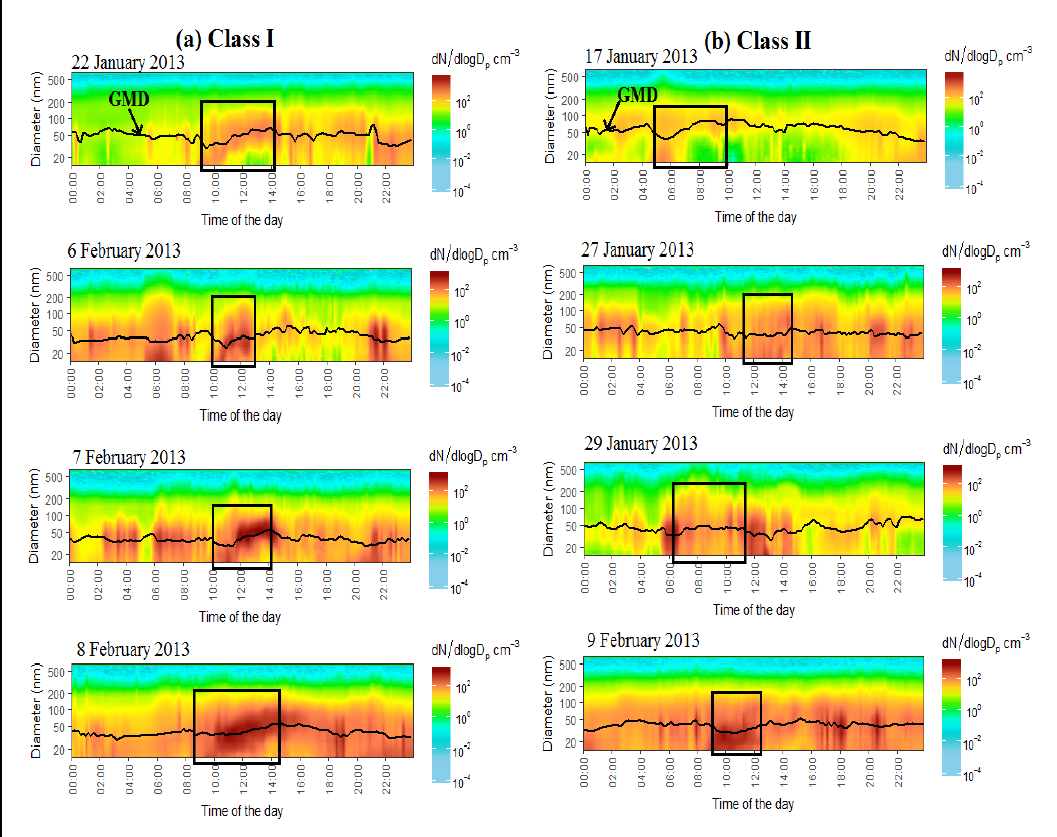
Figure 2. Contour plots of particle number as a function of time and particle diameter for the ( a ) Class I and ( b ) Class II event days identified during the MUMBA campaign. The black line is the geometric mean diameter (GMD). The black rectangular box represents the relevant time of particle formation events. Ten-minute averaged data were used. Note that the y-axis scale is logarithmic. The 24-h backward trajectories plotted for the entire aerosol measurement period revealed that 50% of the sampled air masses arriving at 10:00 Australian Eastern Standard Time, (AEST) were from